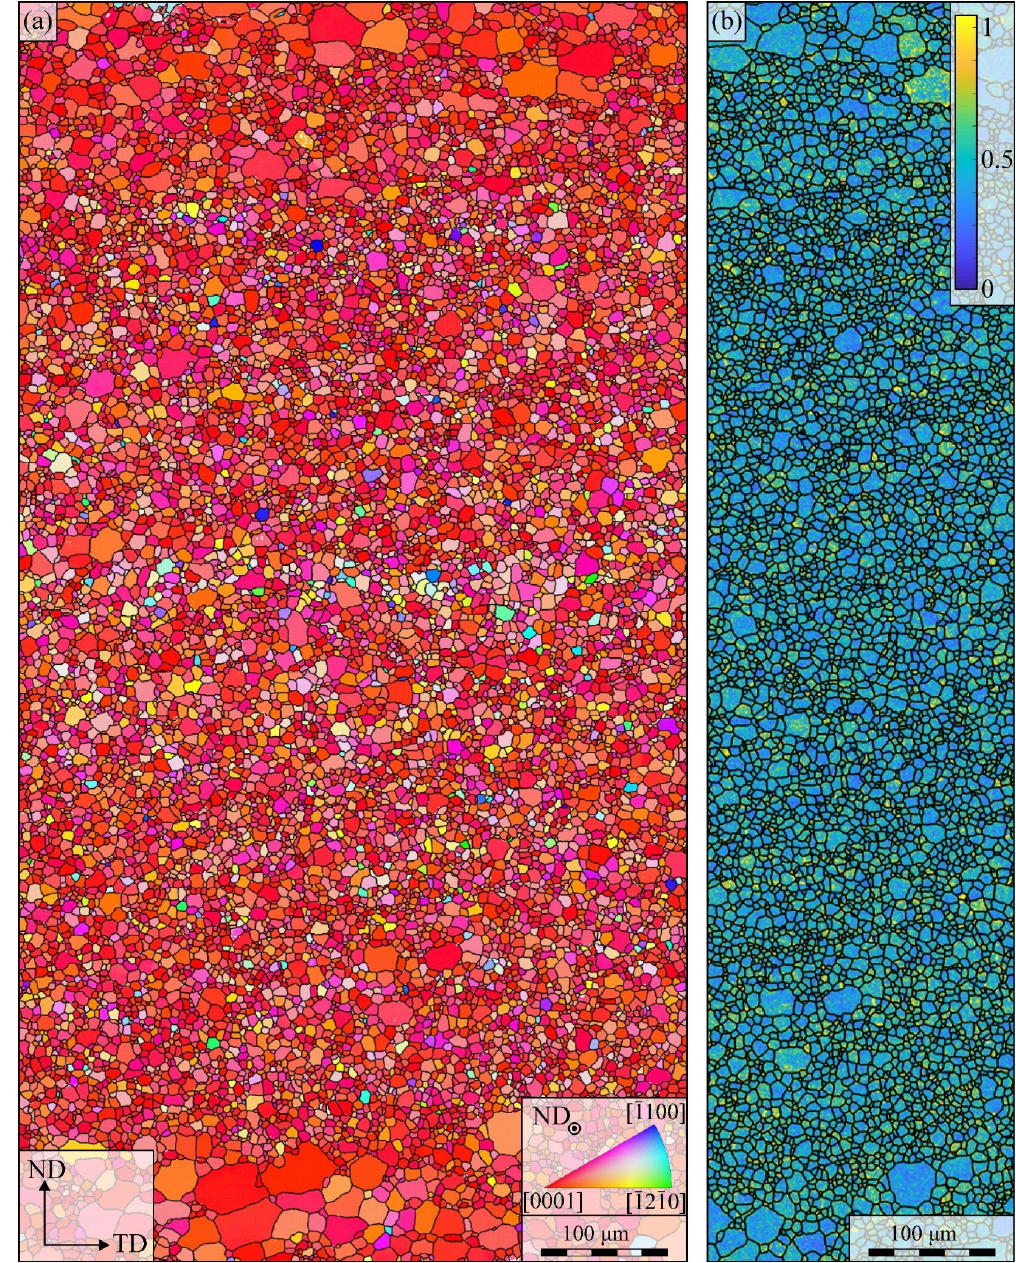
Figure A1. ( a ) Grain orientation map of the specimen cross-section in ND (normal direction)-TD (transverse direction) plane; the color grading indicates the crystal plane normal, which is parallel to ND; ( b ) intragranular misorientation map on the identical area of analysis.